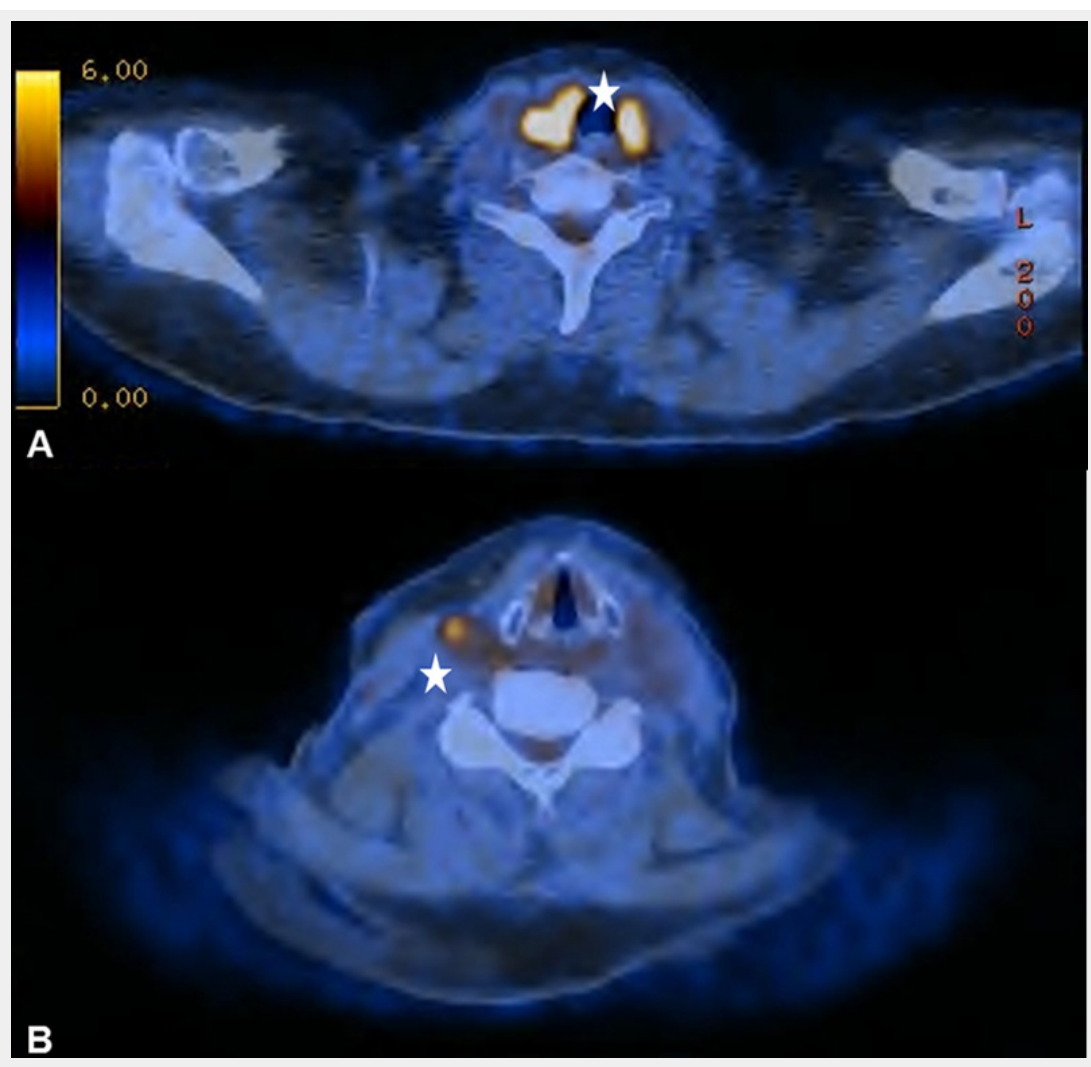
Figure 4 (A) Diffuse bilateral uptake in the thyroid without any morphological correlate in a 67-year old patient with no clinical, ultrasonographical or laboratory signs of thyroid dysfunction. (B) The same patient with corresponding probable reactive